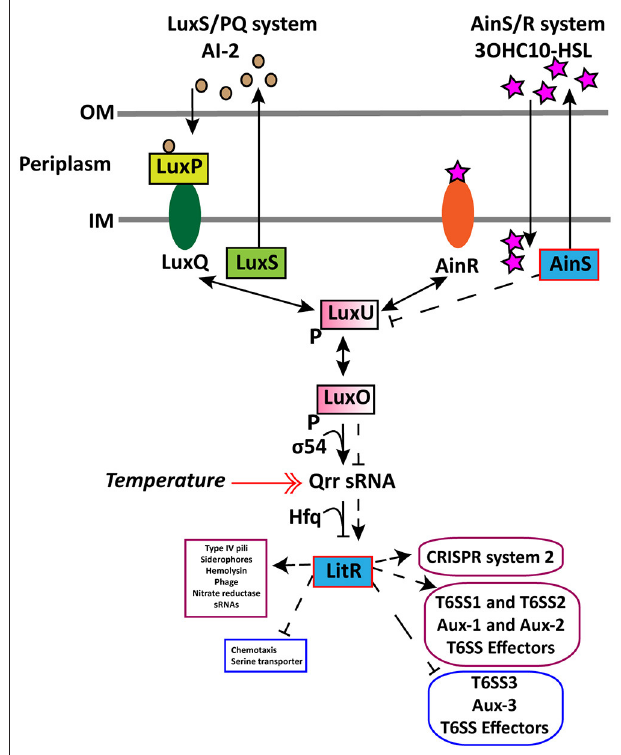
FIGURE 4 | Proposed model for regulation of CRISPR and T6SS in A. wodanis 06/09/139 at 6 ◦ C. The model includes the two QS systems LuxS/PQ and AinS/R in A. wodanis . At low cell density (LCD), when the AIs concentration is low, the receptors (AinR and LuxPQ) may act as kinases and relay phosphate to LuxO via LuxU, which activates the expression of qrr sRNA. The Qrr sRNA inhibits the expression of litR . When the AI concentration is high at high cell density (HCD), they bind to the receptors to dephosphorylate LuxO and inactivate qrr sRNA. Inactivation of qrr sRNA, in turn, activates litR , which regulates many genes. Arrowheads at both ends indicate phosphorylation relay, and the symbol “P” indicates the phosphorylated state. AinS seems to affect luxU negatively and the litR expression positively. LitR seems to positively affect the genes involved in T6SS1, T6SS2, Aux-1, Aux-2, T6SS effectors and CRISPR system 2 and, conversely, affect T6SS3, Aux-3 and T6SS effectors negatively. Thin line and dashed line with arrowhead indicate regulation at LCD and HCD, respectively, where arrowheads indicate increased expression ( + ) and bars indicate decreased expression (-). A double arrowhead red line indicates the increased expression of qrr sRNA at 12 ◦ C compared to 6 ◦ C. Genes with significantly higher and lower expression are presented in purple and blue boxes,